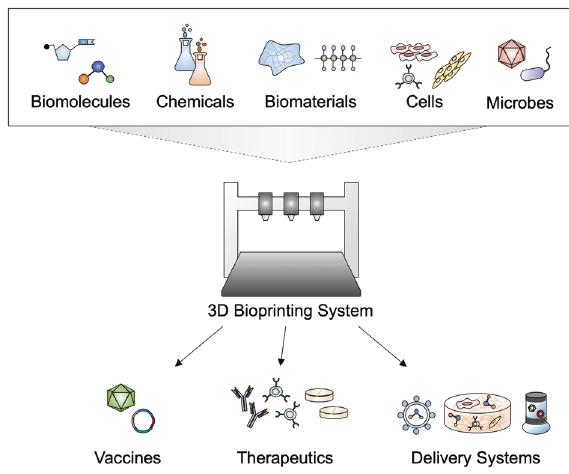
Fig. 6 Applications of 3D bioprinting for manufacturing of vaccines, therapeutics, and delivery